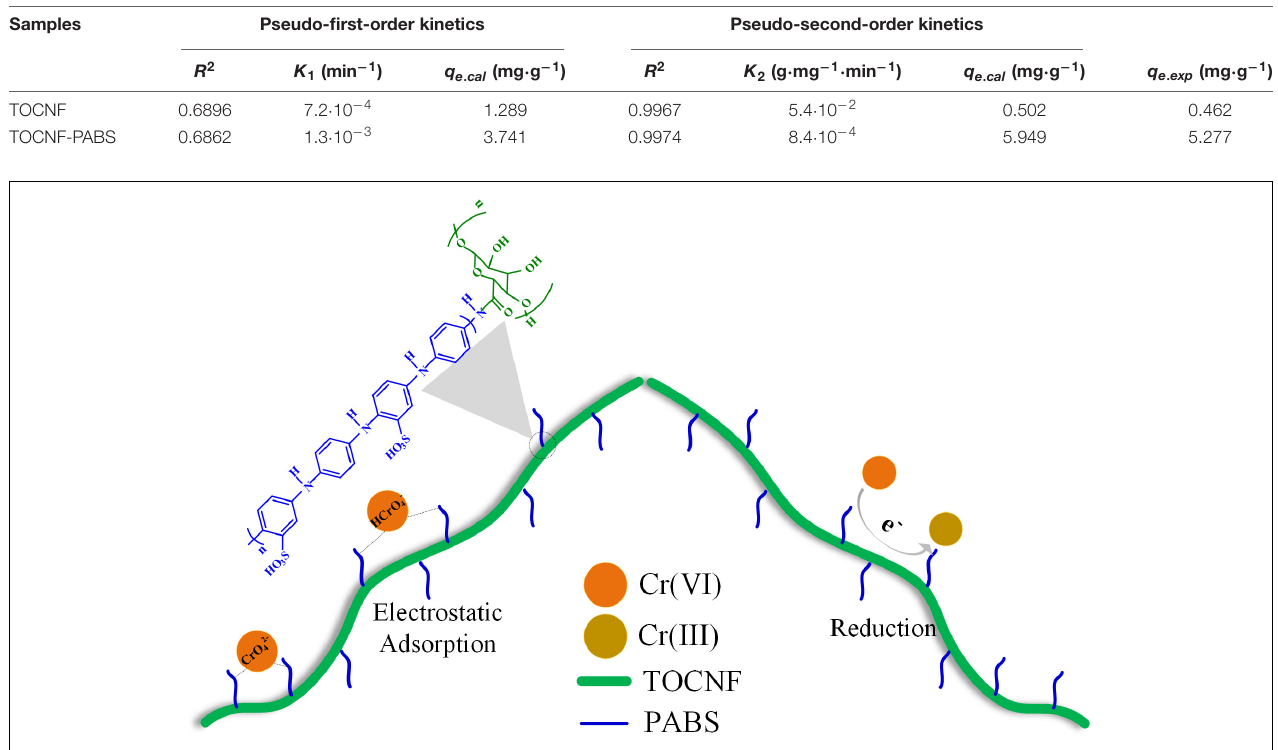
TABLE 3 | Characteristic parameters of kinetic equations for the adsorption of Cr(VI) onto TOCNF and TOCNF-PABS. Samples